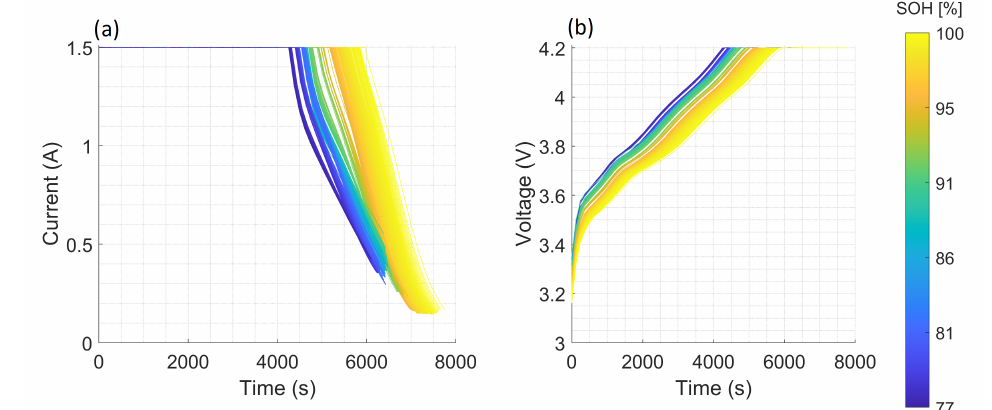
Figure 4. The acquired ( a ) current (A) and ( b ) voltage (V) are plotted as time series for each indepen- dent charging